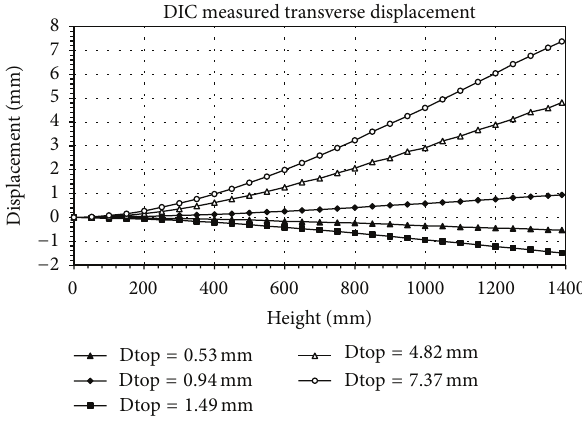
Figure 8: Displacement curve.